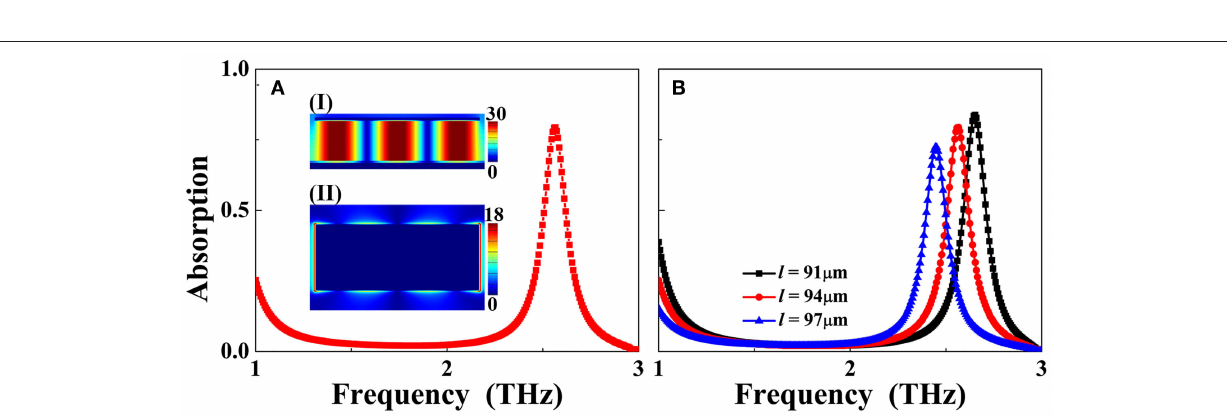
insulating medium layer, the periodic dimensions of basic cell, the calculation model and its boundary conditions are unchanged in the whole manuscript unless otherwise specified. In other words, except for the introduction of air gaps into the rectangular patch, there is no other parameter changes for the dual-band and triple-band absorption in the following sections. Therefore, the advantage of this method (by introducing air gaps into the rectangular patch) in this manuscript is that the multiple-band absorption can be obtained without increasing the cell sizes horizontally and vertically, which is totally different from the previous design strategies.